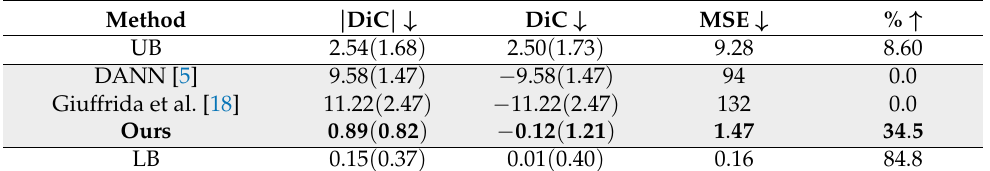
Table 3. Pedestrian counting domain adaptation experiments results using the UCSD dataset. The Vidf scene is used as source domain whereas the Vidd scene is used as target